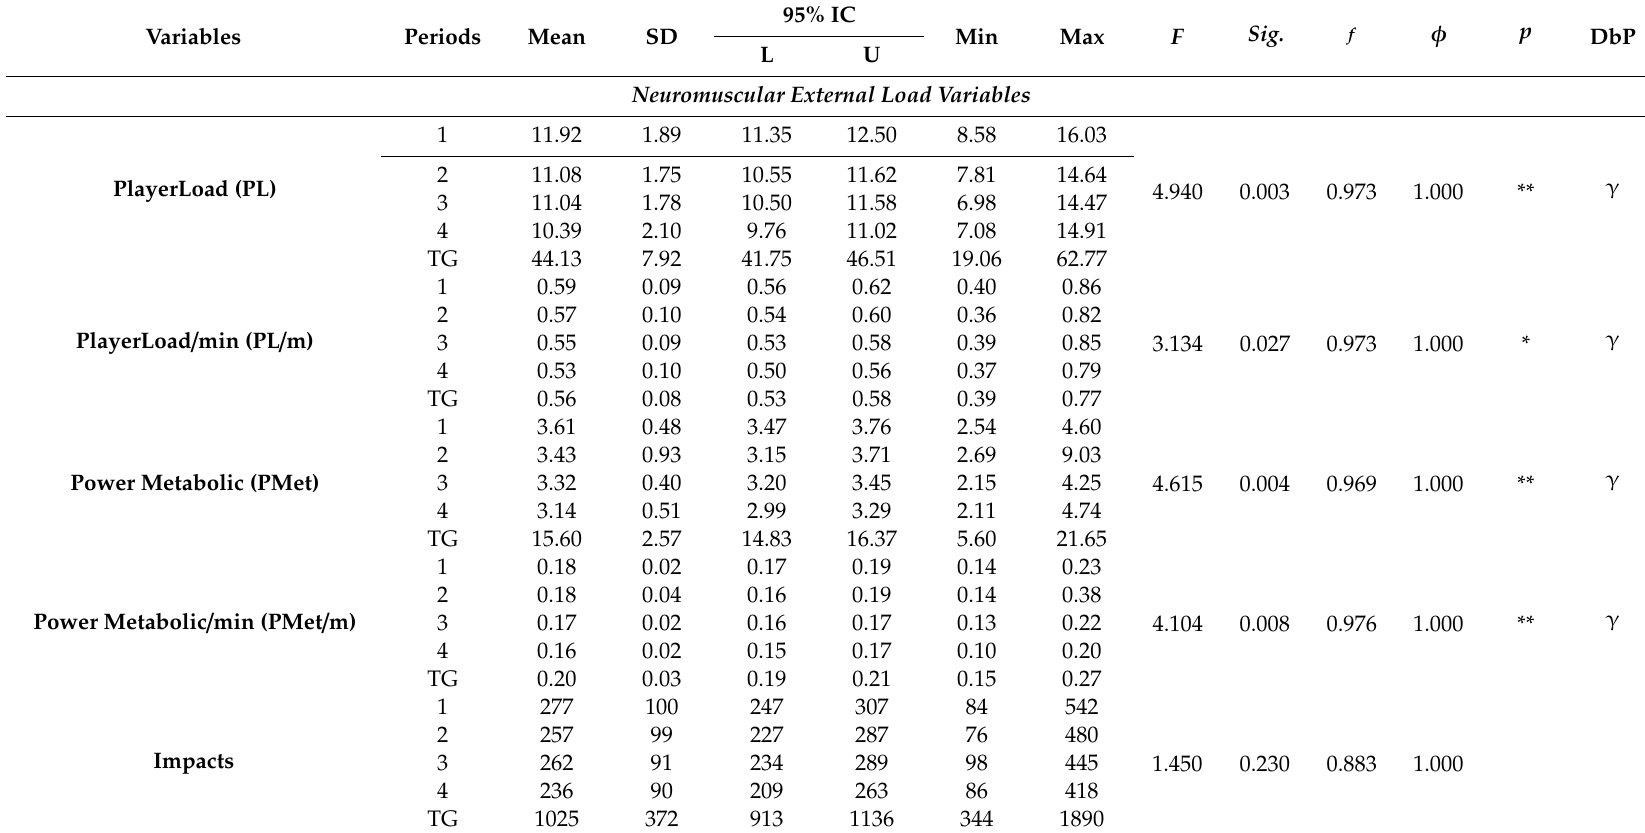
Table 4. Descriptive and Inferential Results of the External Load Variables (Neuromuscular